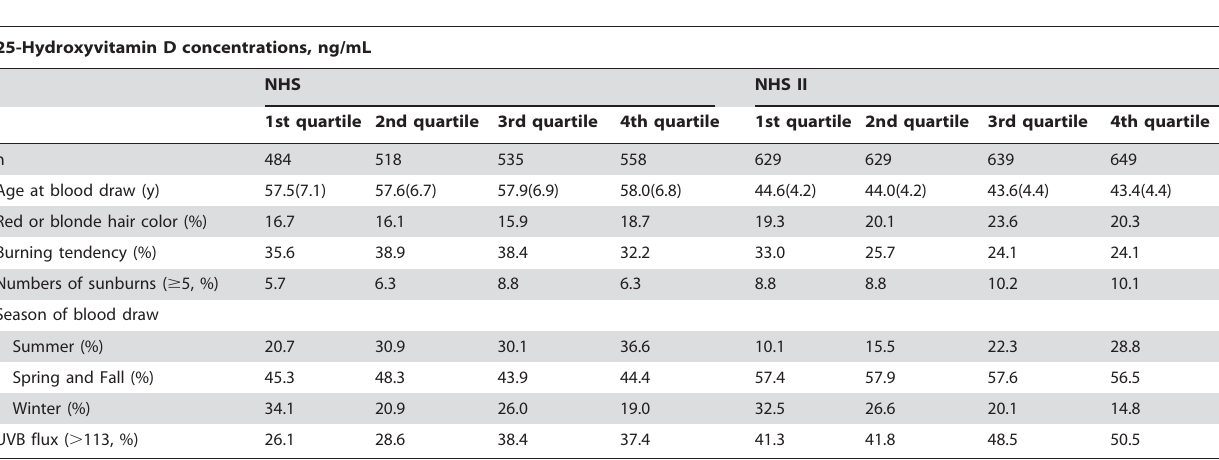
Table 1. Characteristics by quartile of plasma vitamin D concentrations in NHS and NHS